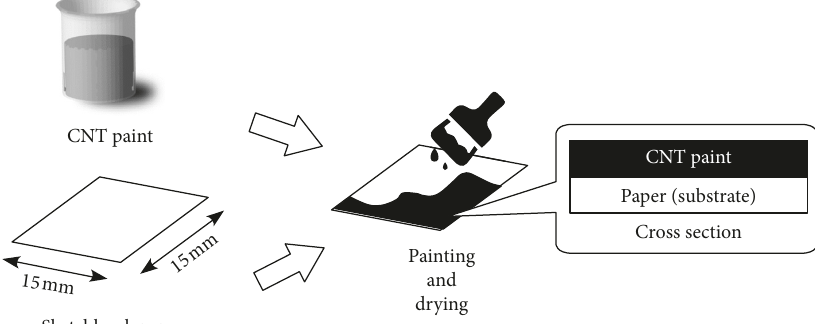
Figure 2: Schematic of making method for electrodes.